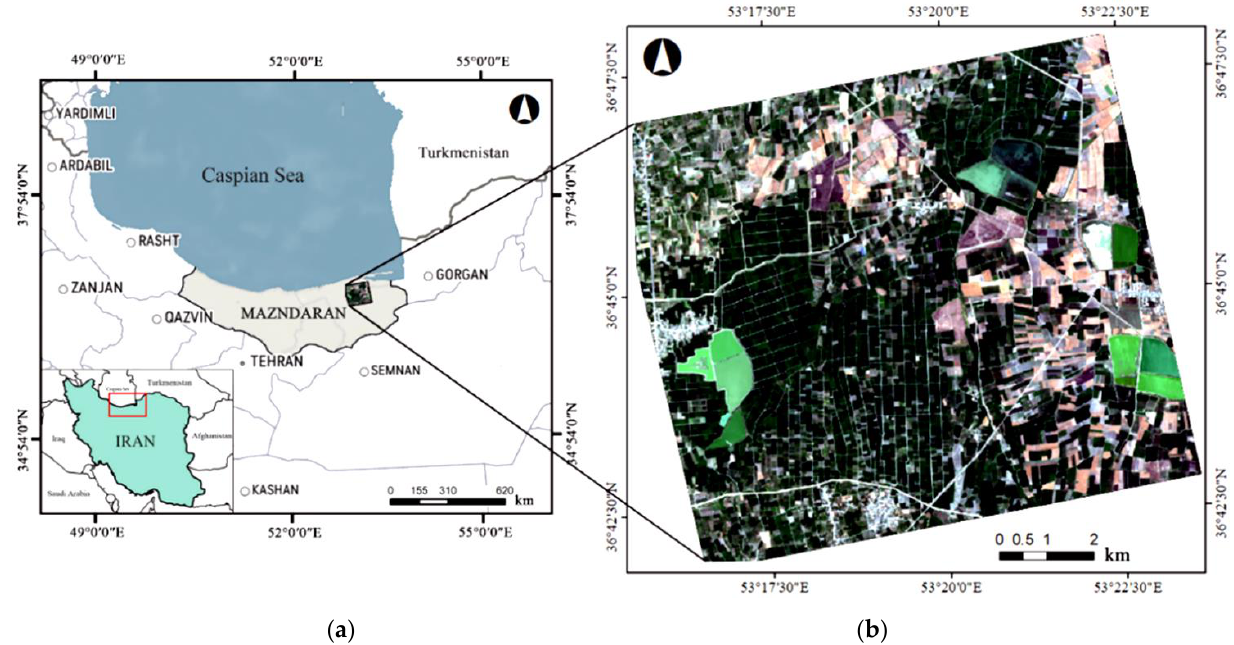
Figure 1. ( a ) Geographical location of the study area, and ( b ) a false-color composite NDVI image (R: April, G: June, and B: July). April, G: June, and B: